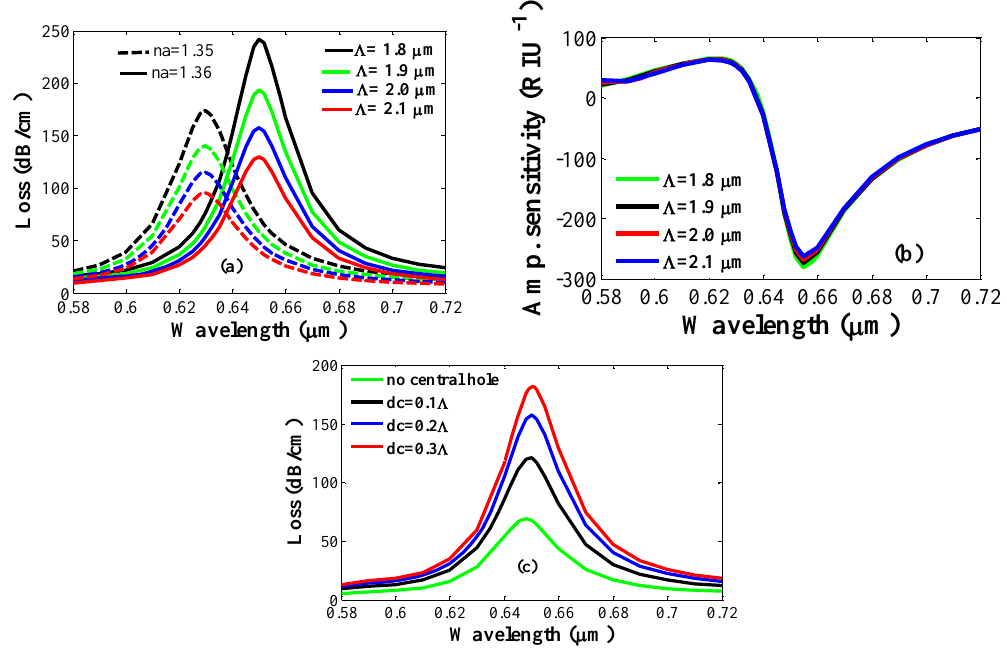
Figure 5. ( a ) Fundamental loss spectrum for increasing pitch values from 1.8 to 2.1 µm; ( b ) amplitude sensitivity for different pitch values with an analyte RI of 1.35; ( c ) loss spectrum for different central air-hole diameter with d = 0.4Λ and t = 40 nm with an analyte RI of 1.36.